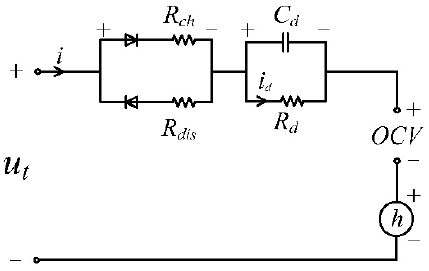
Figure 1. The improved first-order resistance-capacitance model with one-state hysteresis.